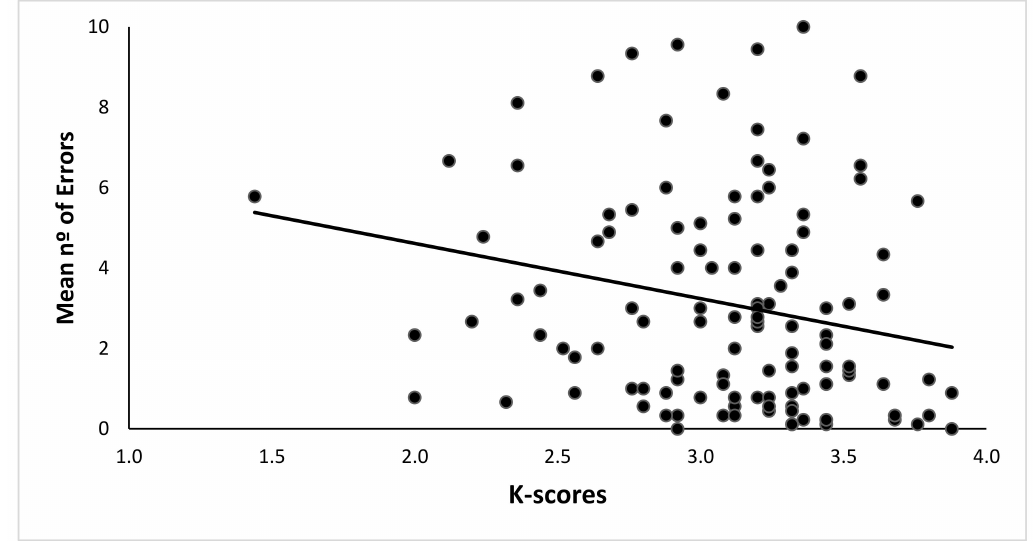
Figure 3. Dispersion of mean number of errors in the Spatial Memory Task due to the K-index. High K indexes are correlated with better performance, and thus, a smaller number of errors were